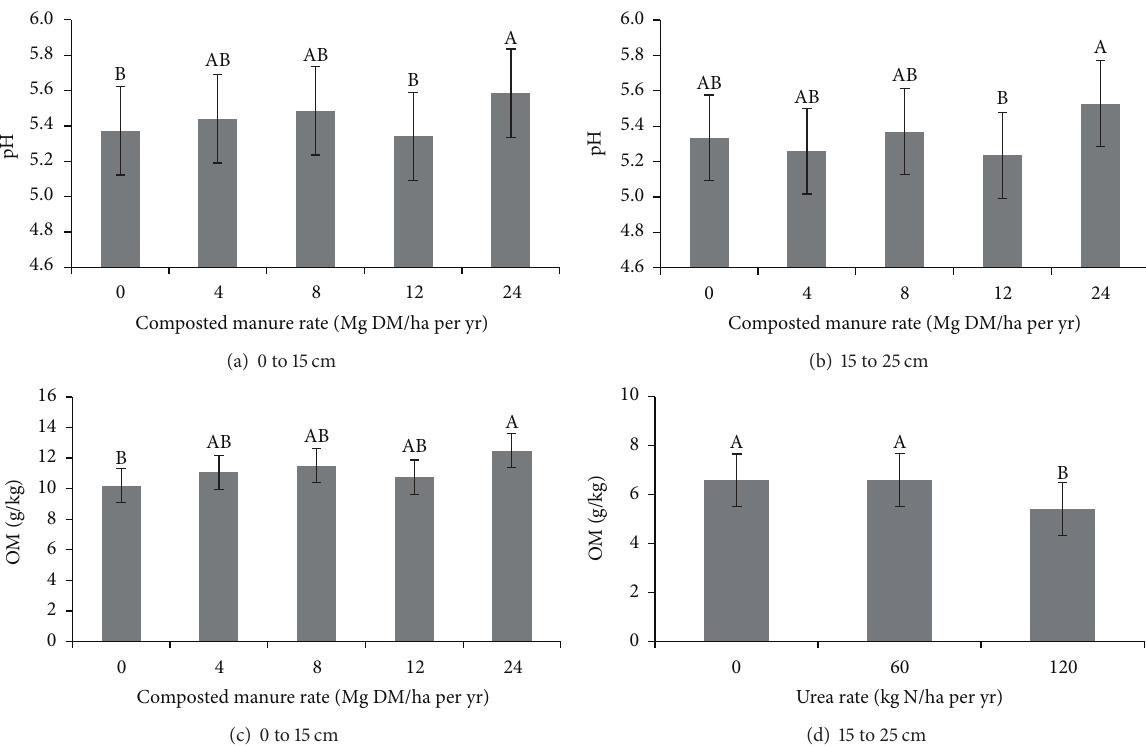
Figure 1: Postexperiment pH least squares means for composted manure rates in the 0 to 15cm ((a), 𝑃 = 0.0071 ) and 15 to 25 cm strata ((b), 𝑃 = 0.0460 ) and soil organic matter (OM) least square means for compost treatments in the 0 to 15cm stratum ((c), 𝑃 = 0.0087 ) and urea treatments in the 15 to 25 cm stratum ((d), 𝑃 = 0.0035 ). pH models contained preexperiment soil pH and OM models contained preexperiment OM (Table 10). Error bars are ± 1 SE of the mean. Bars connected by the same letter are not significantly different ( 𝑃 ≤